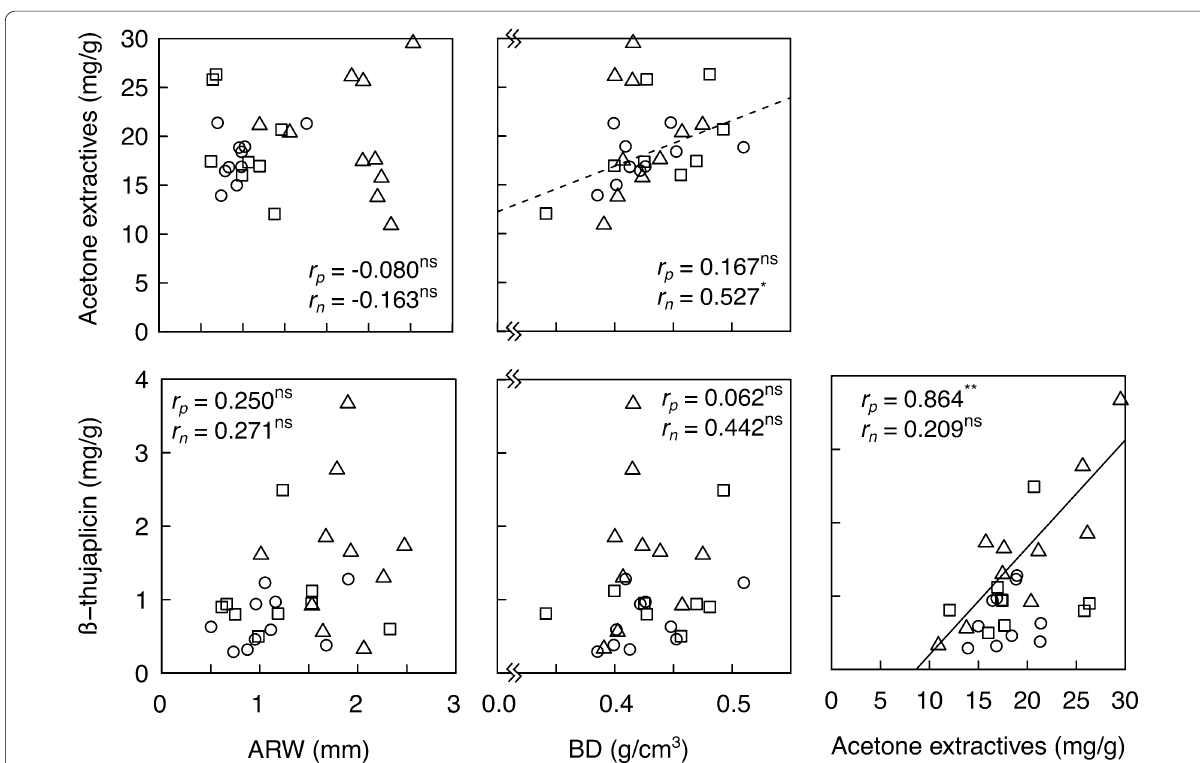
Fig. 1 Relationships between acetone extractives or β-thujaplicin contents and annual ring width (ARW) or basic density (BD). Square, circle, and triangle indicate stands A, B, and P, respectively. Solid, dashed, and dotted and dashed lines indicate the regression lines of whole sample ( n 29), = natural [combined data of stands A and B ( n 19)], and plantation stands [P ( n 10)], respectively. The “ r p and r n ” are the correlation coefficients of = = plantation [P ( n 10)] and natural [combined data of stands A and B ( n 19)] stands, respectively, all sampled trees ( n 29). **, *, and ns indicate = = = that the correlation coefficients are significant ( p < 0.01 and p < 0.05) and not significant ( p > 0.05), respectively. Solid and dashed indicate the regression lines of plantation and natural stands,